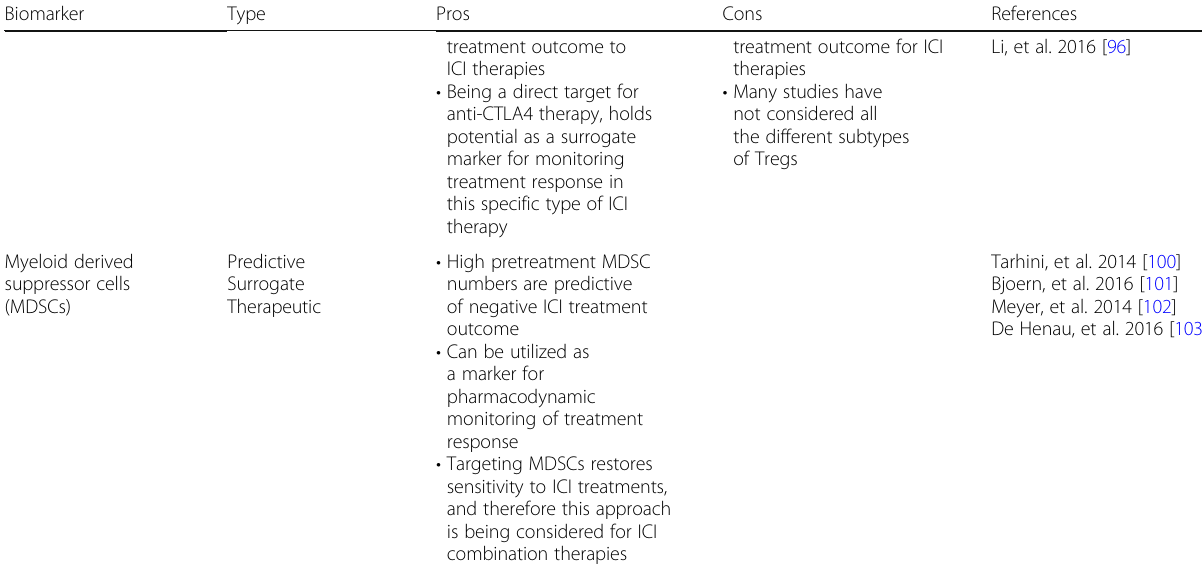
Table 1 Summary of biomarkers currently under investigation for Immune Checkpoint Inhibition (ICI) therapies (Continued)